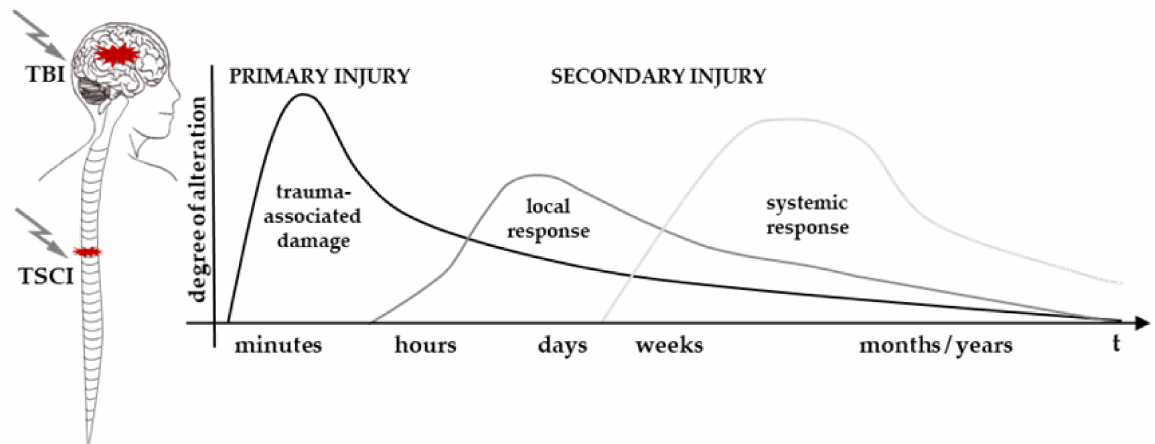
Figure 1. Pathophysiological course of events following acute damage of the central nervous system: TSCI and TBI. Once the primary injury occured, which represents the initial mechanical insult, the secondary injury is induced within minutes as a local response. Through the additional compromised blood–brain and blood–spinal cord barrier and further mechanisms discussed in this review, the local response evolves into a systemic one, followed by regenerative processes. Abscissa axis = time; ordinate axis = degree of relative alteration. Graphic adapted from [26]. Abbreviations: TBI = traumatic brain injury, TSCI = traumatic spinal cord